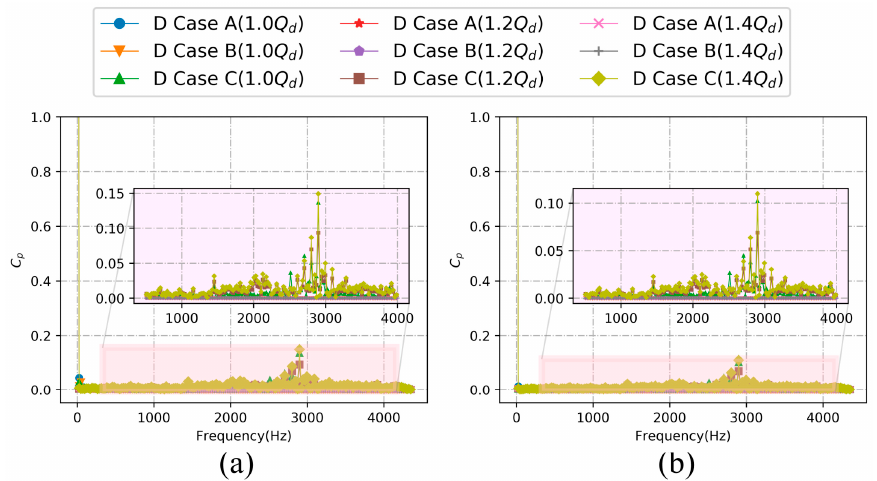
Figure 21. Frequency domain history of pressure fluctuation in outlet pipe flow passage at the locations of: ( a ) D1 and ( b ) D2.